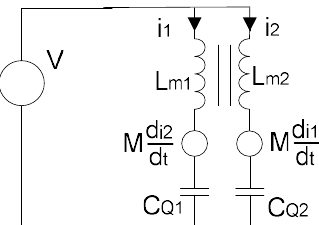
Figure 6. Approximated equivalent circuit for no energy exchanging between the primary side and secondary side.